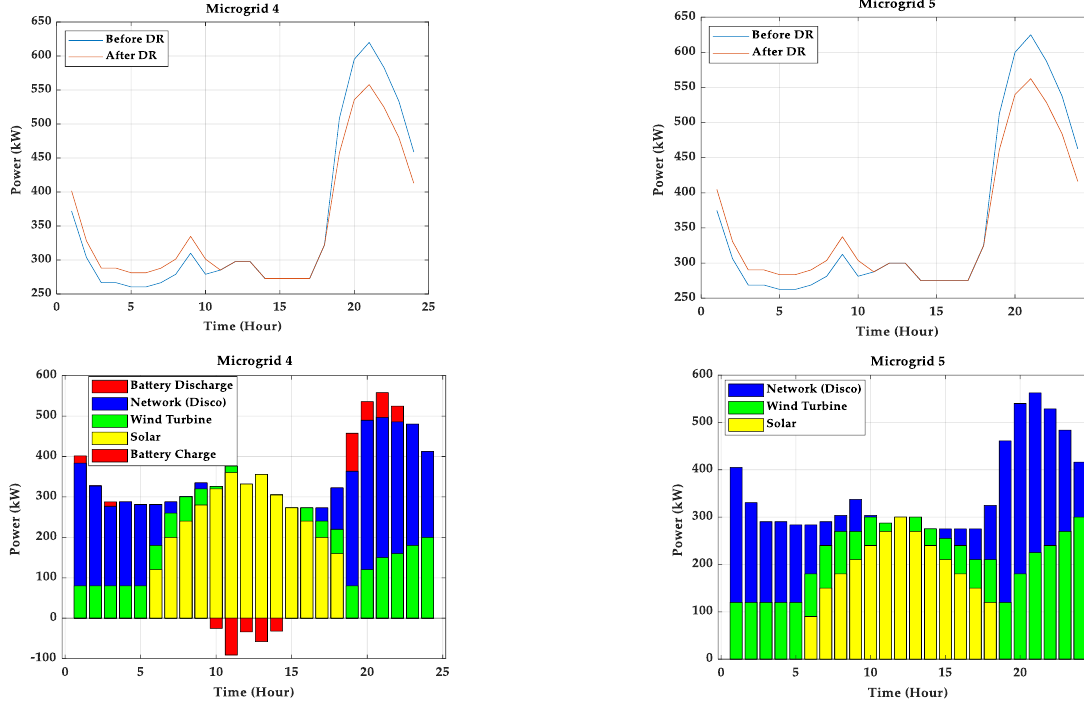
Figure 19. Impact of DR on MGs 4 and 5.